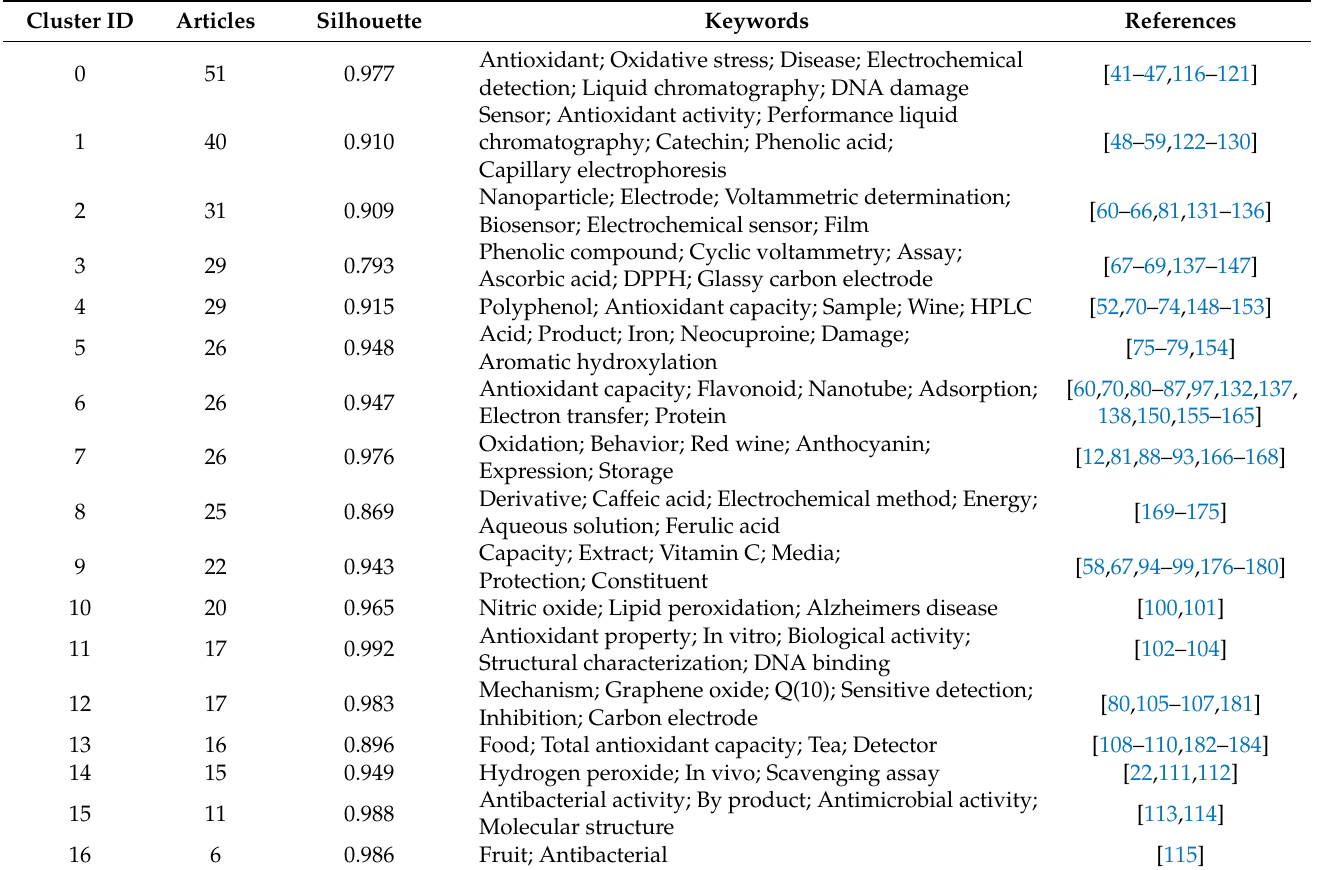
Table 4. Knowledge clusters in the field of electrochemical detection of sunset yellow on keyword co-occurrences for each